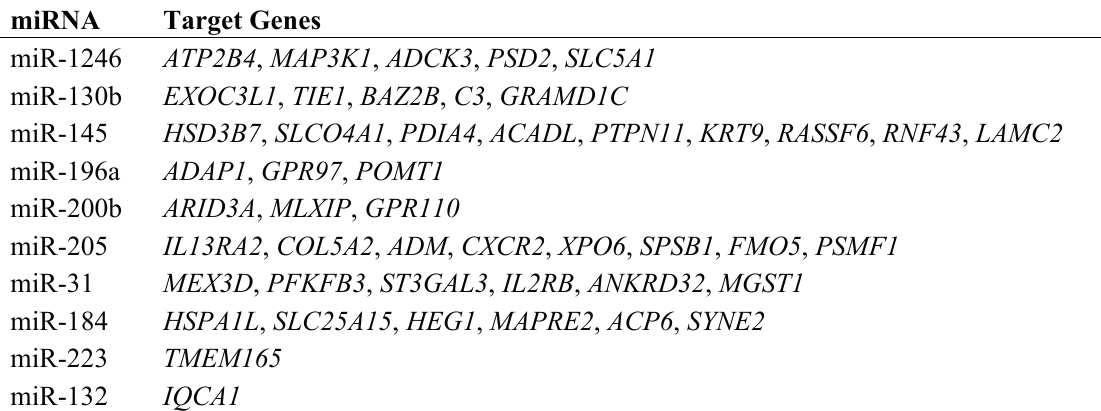
Table 2. Partial list of predicted microRNA gene